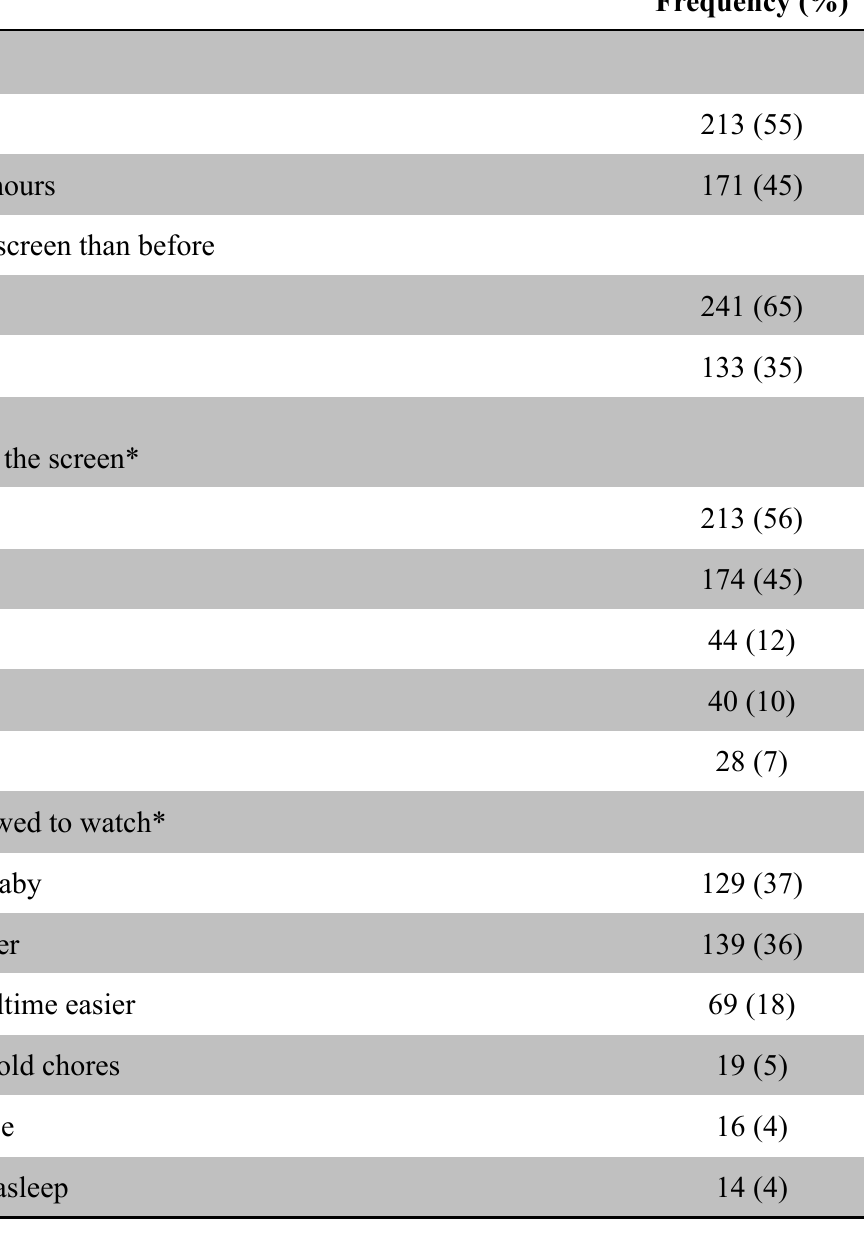
Table 1: Information related to screen use during COVID-19 (n=384)